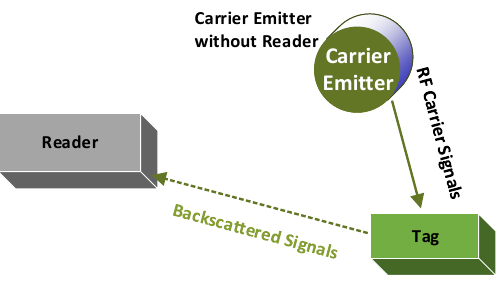
Figure 9. Bistatic Scatter Communication.